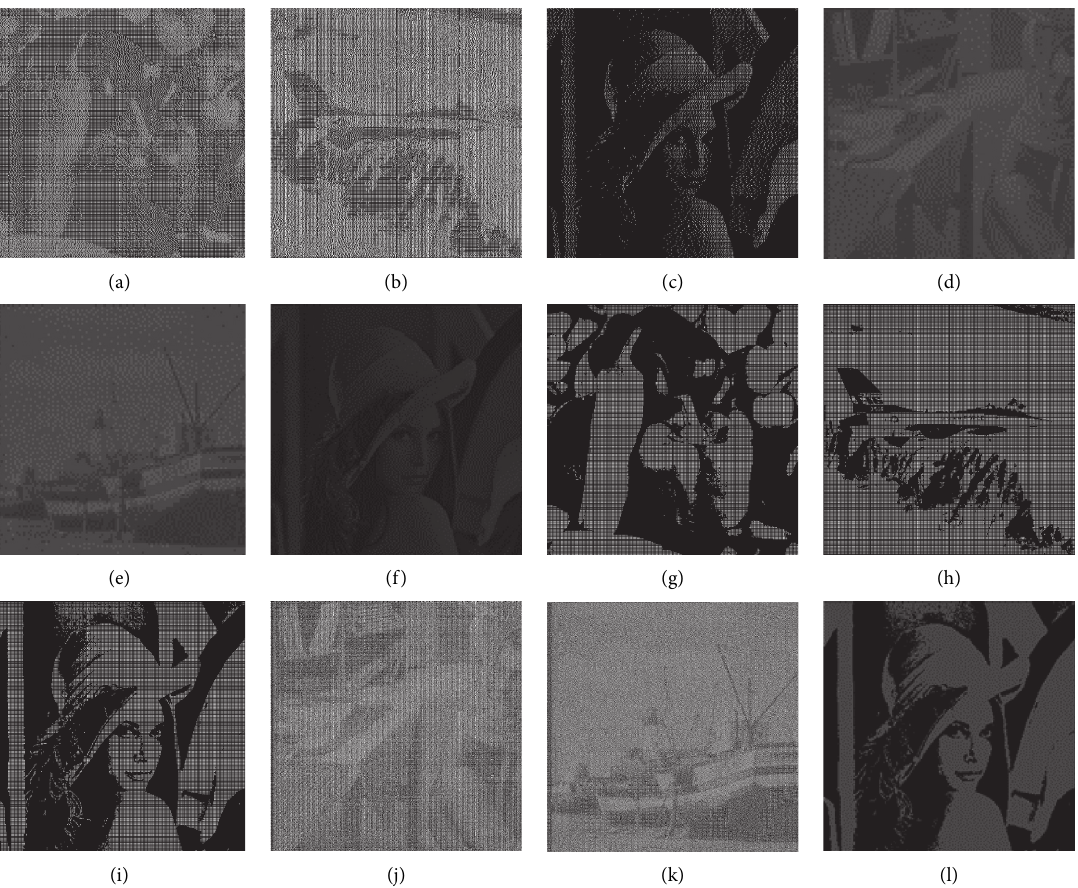
Figure 2: The PSNR comparison of Chen’s [18] VCS and our scheme. The first share halftone image ((a) pepper and (d) Barbara), the second halftone image ((b) airplane and (e) boat), and the stacked image ((c, f), Lena) are generated by Chen’s [18] VCS. The first share halftone image (g, j), second halftone image (h, k), and the stacked image (i, l) are generated by our scheme. (a) 43.43, (b) 42.43, (c) 41.24, (d) 42.97, (e) 43.65, (f) 42.02, (g) 51.79, (h) 50.94, (i) 51.42, (j) 52.12, (k) 49.63, and (l)